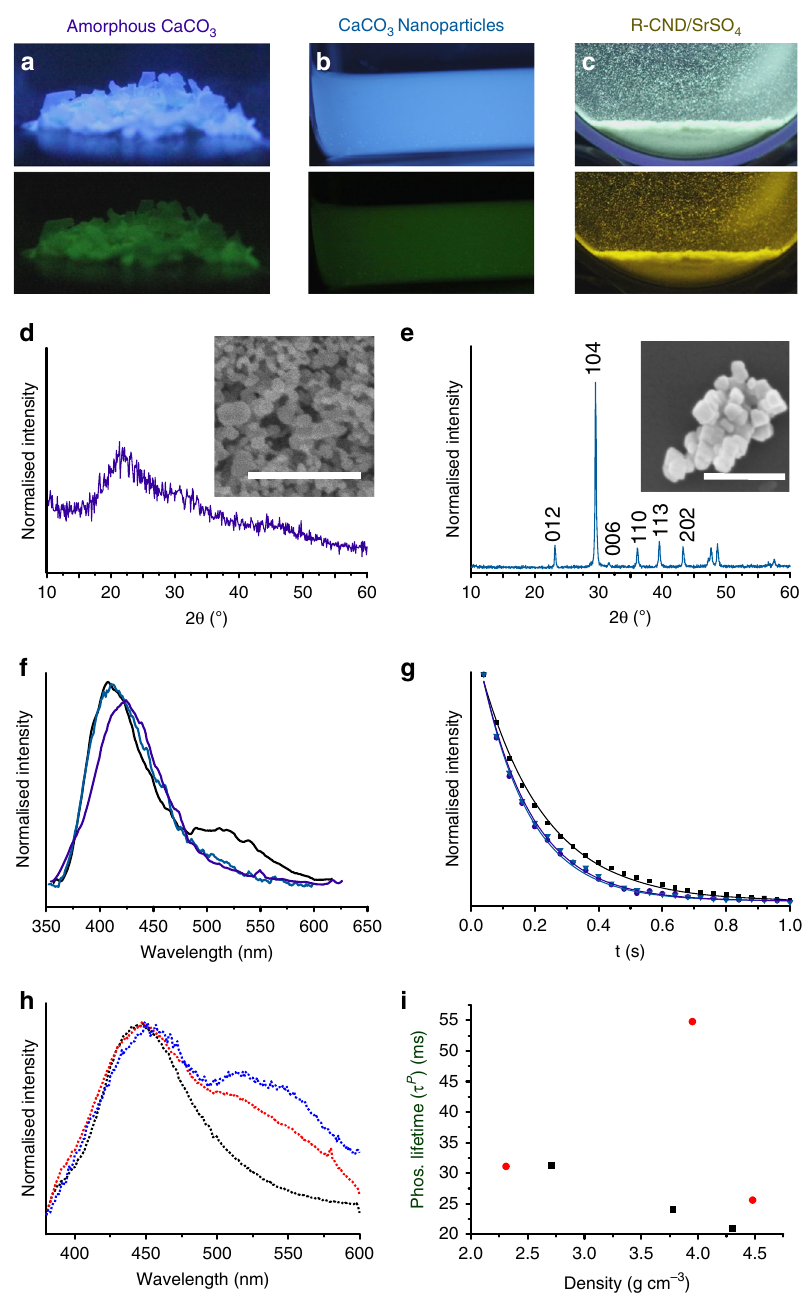
Fig. 4 Exploring the impact of host phase synthesis and carbon nanodot (CND) precursors on photoluminescent (PL) behaviour. Photographs with, and immediately after the removal of, UV (365 nm) excitation of folic acid-derived CND (F-CND) nanocomposites with a amorphous CaCO 3 (amorphous calcium carbonate (ACC)) and b calcite (CaCO 3 ) nanoparticles, and c ribo fl avin – derived CND (R-CND) nanocomposites with SrSO 4 . Powder X-ray diffraction (pXRD) patterns of d ACC and e CaCO 3 nanoparticles, where the peaks are indexed to calcite. Scanning electron microscopy